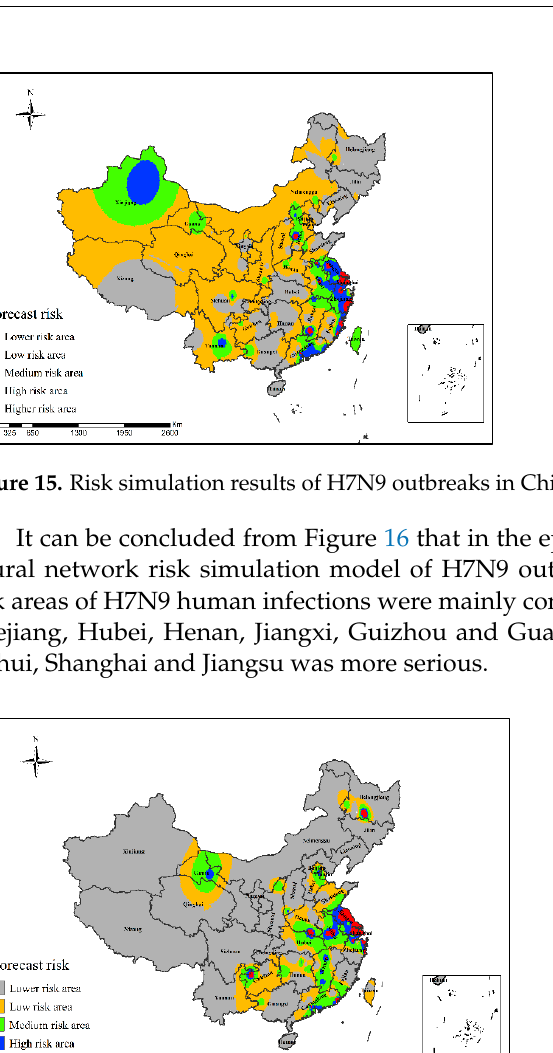
Figure 14. Risk simulation results of H7N9 outbreaks in China in 2014.